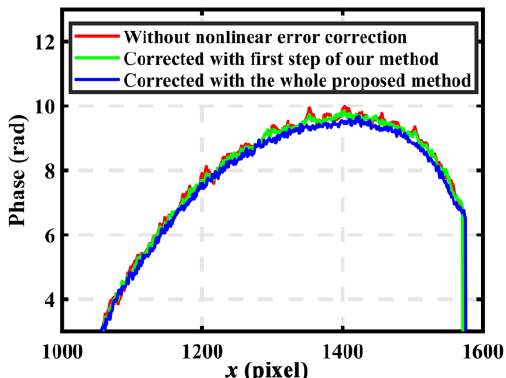
Figure 10. One cross-section of the recovered absolute phases of the sculpture.